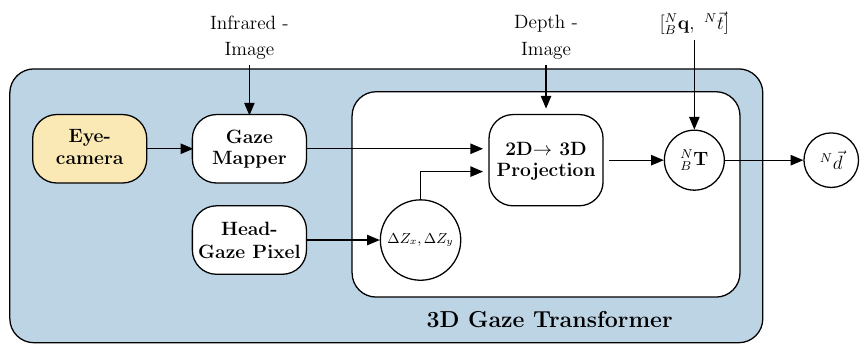
Figure 5. Block diagram of the 3D gaze estimation. The eye cameras measurements are mapped onto the infrared stream to generate a pixel pair whereas the head pose pixel pair is a fixed value. Both pixel pairs are passed to the gaze transformer to reproject the 2D pixel to 3D local camera coordinates. This local vector is lastly transformed into the world coordinate system forming N (cid:126) d